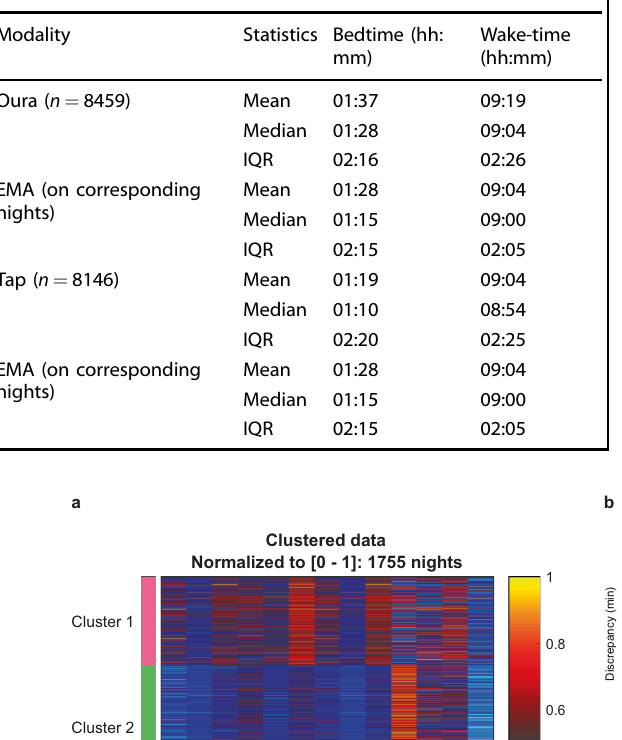
Table 2. Comparison of sleep estimates with self-reported EMA as reference.